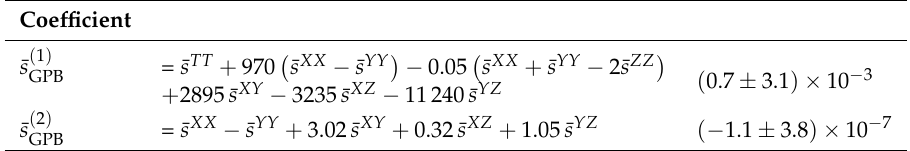
Table 5. Estimations of the SME coefficients from a postfit data analysis based on Gravity Probe B (GPB)